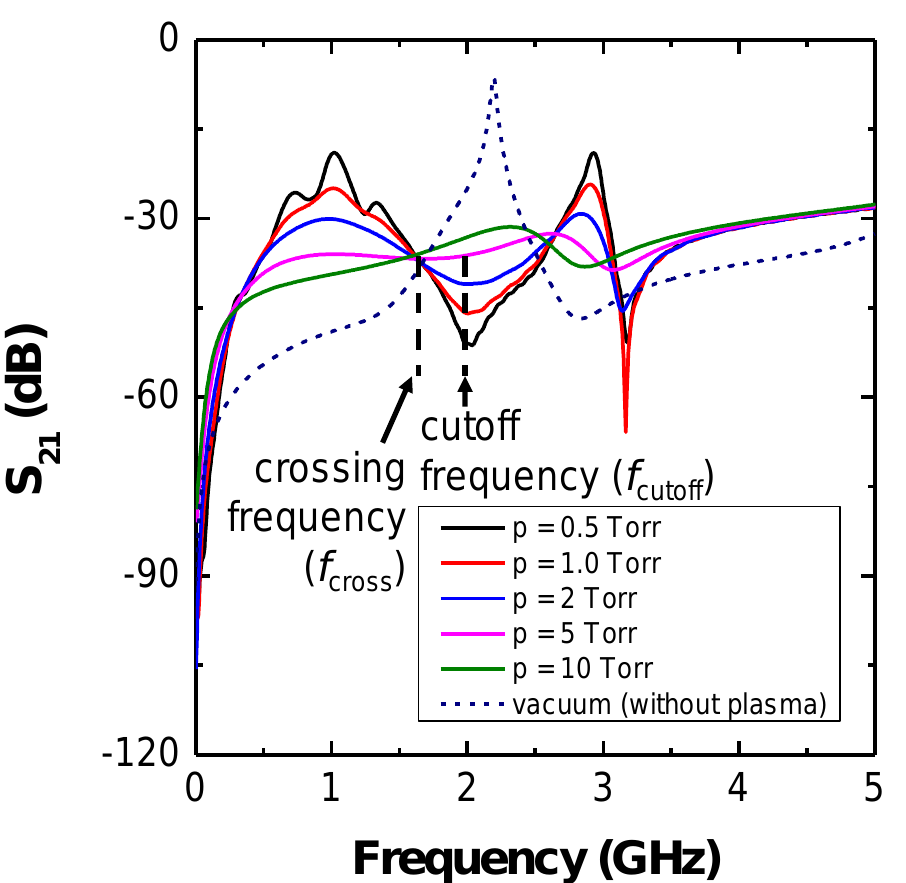
Figure 2. Simulated S 21 spectra at various pressures with an electron density of 5 × 10 10 cm − 3 , tip length of 5.0 mm, sheath width of 0.234 mm, and tip distance of 4